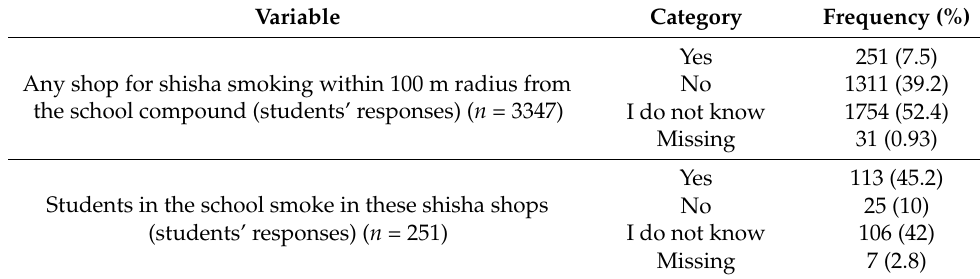
Table 4. Shisha smoking practice in the school environment in Ethiopia (March